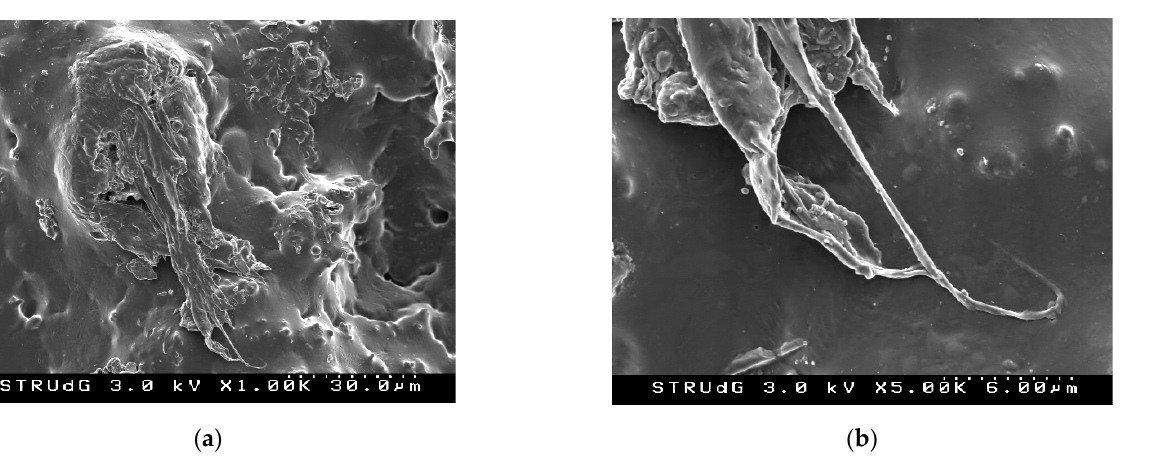
Figure 3. Scanning electron microscopy images of 90% lignin + 10% glycerin thermoplastic lignin: ( a ) magnification at 30 µm; ( b ) magnification at 6 µm.